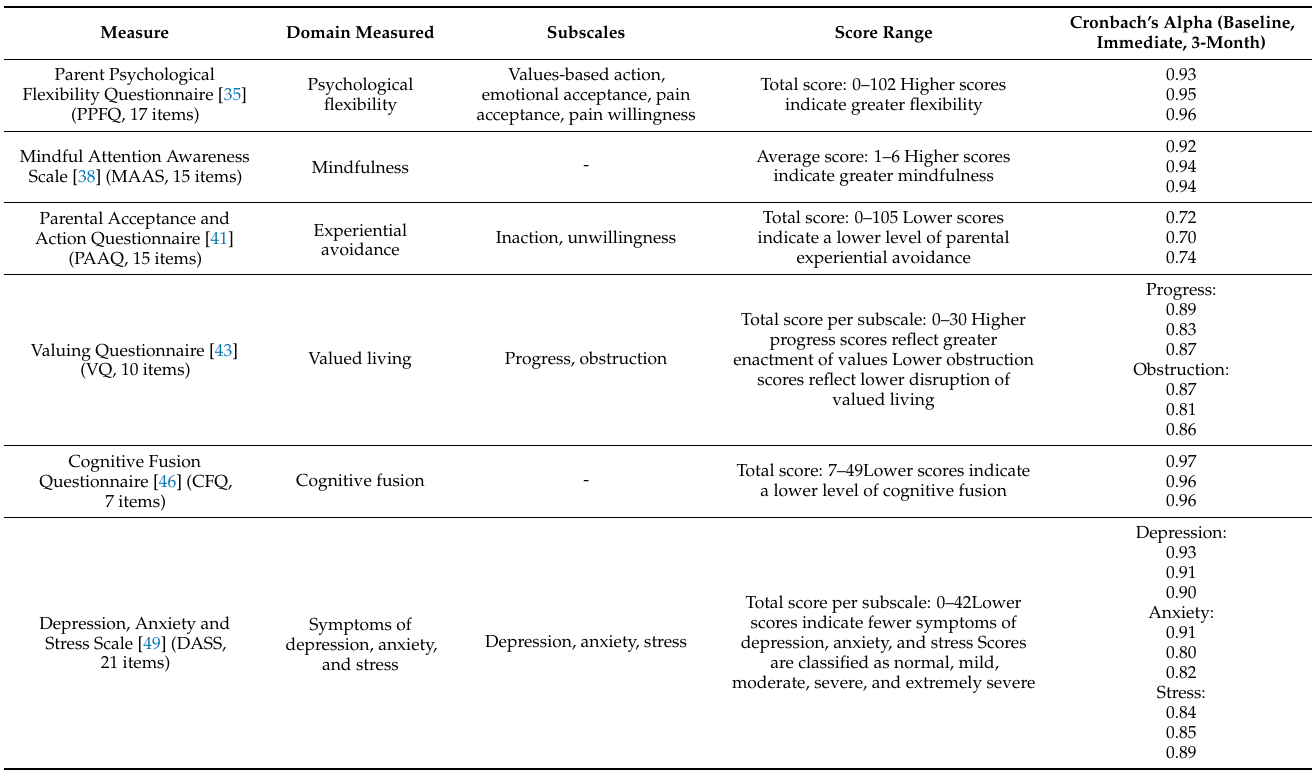
Table 2. Psychosocial measures assessed at baseline, immediately postintervention, and 3-months